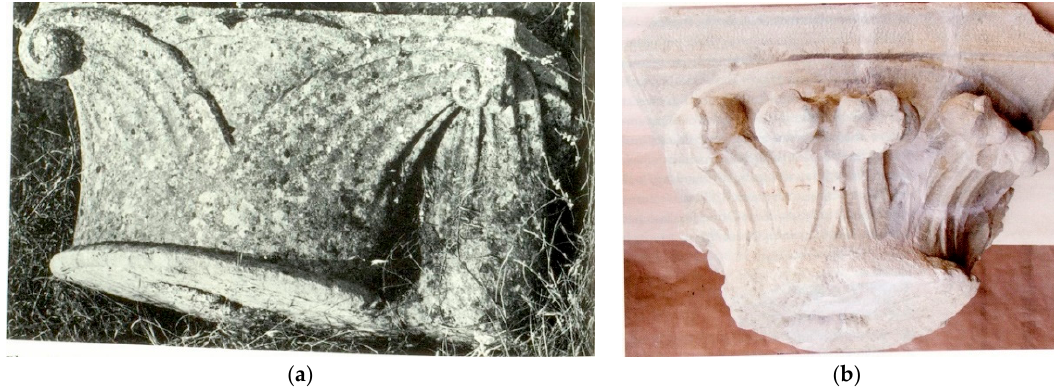
Figure 25. Cistercian crocket capitals in the 13th-century Morea. ( a ) Zaraka Abbey. Source: (Kitsiki-Panagopoulos 1979); ( b ) Our Lady of Isova. Source: (Athanasoulis 2013). Arts 2020 , 9 , x FOR PEER REVIEW